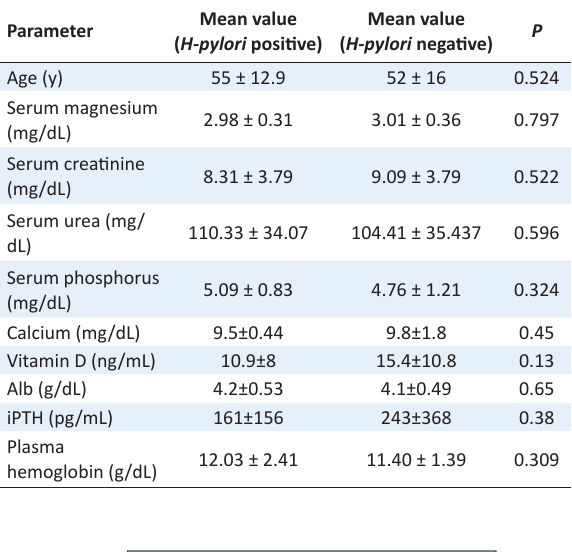
Table 2. Demographic and biochemical data of patients infected with Helicobacter pylori and patients negative for Helicobacter pylori